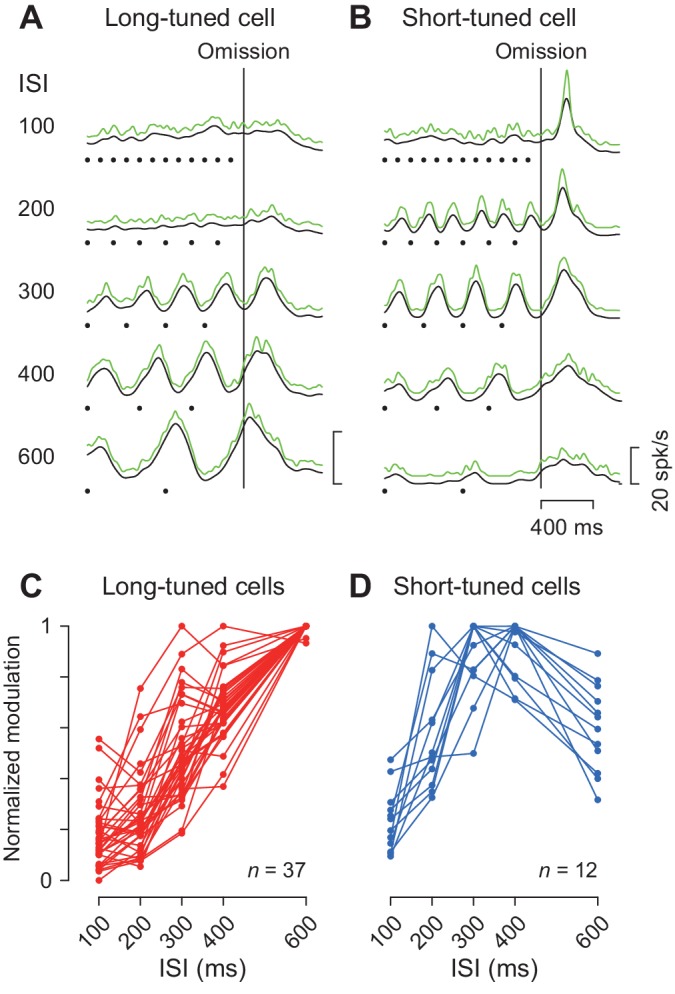
Comparison of different Gaussian filters.Same format as in Figure 4 except that a narrower Gaussian kernel (σ = 15 ms) was used. (A, B) Spike density profiles of two example neurons for different ISIs with different kernels (15 ms, green traces; 30 ms, black traces, same as in Figure 4). Spike density traces with a narrower kernel were shifted vertically for presentation purpose only. (C, D) Duration tuning computed with a narrower kernel.